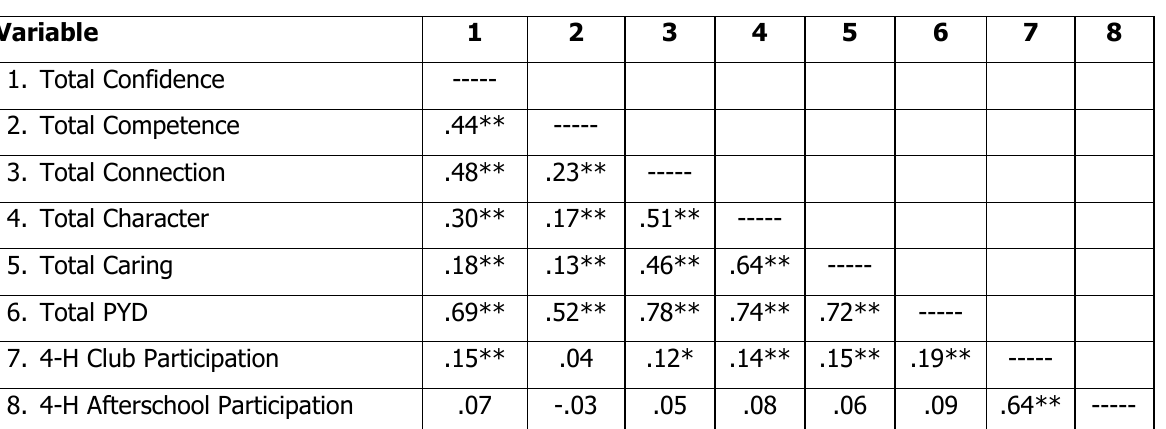
Pearson’s Correlations Among the Five Cs, PYD, 4-H Club Participation and 4-H Afterschool